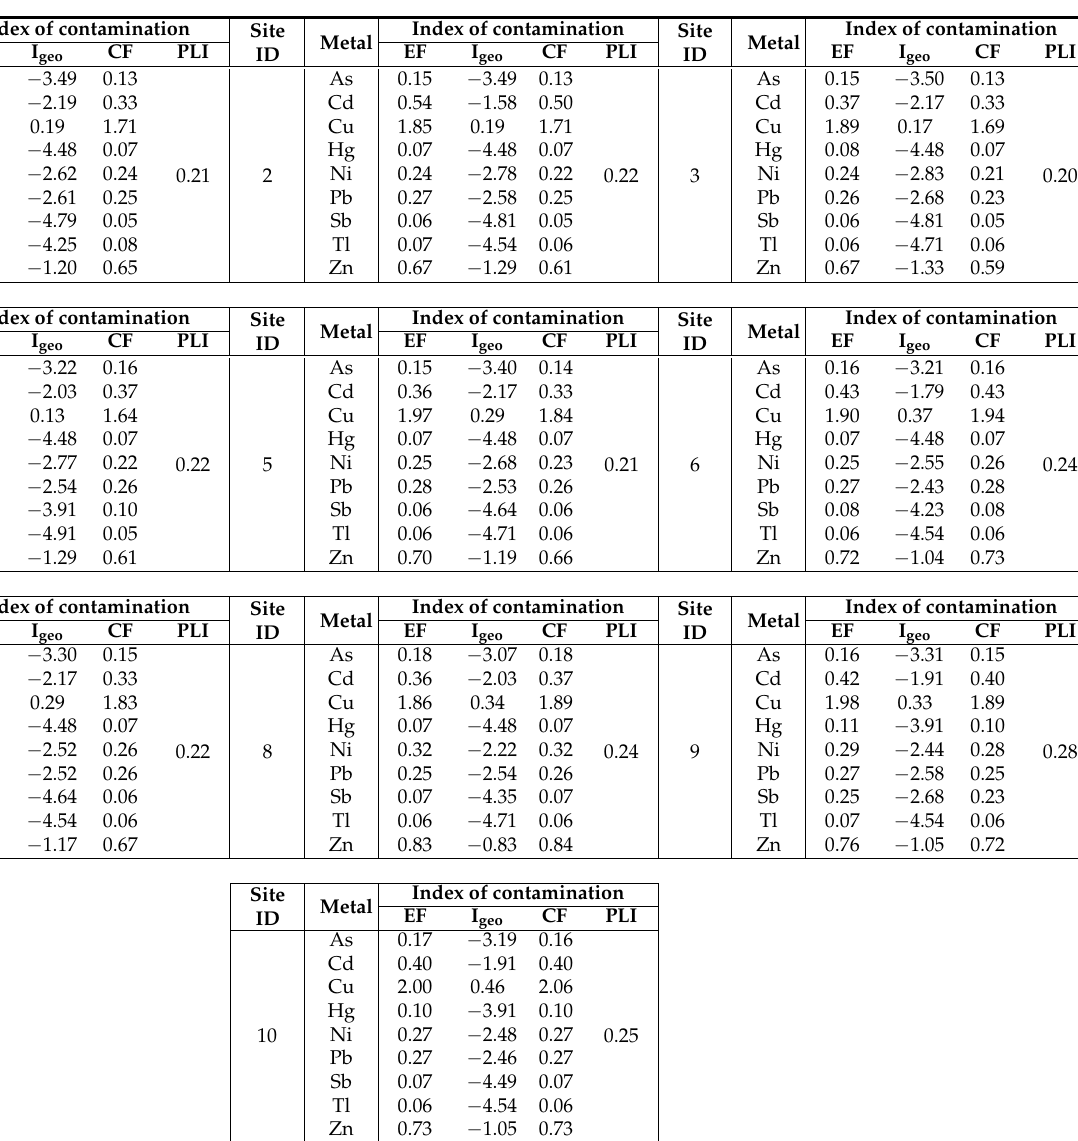
Table 3. Calculated values of the Enrichment Factor (EF), Geo-accumulation Index (Igeo), Contami- nation Factor (CF) and Pollution Load Index (PLI) for all the investigated